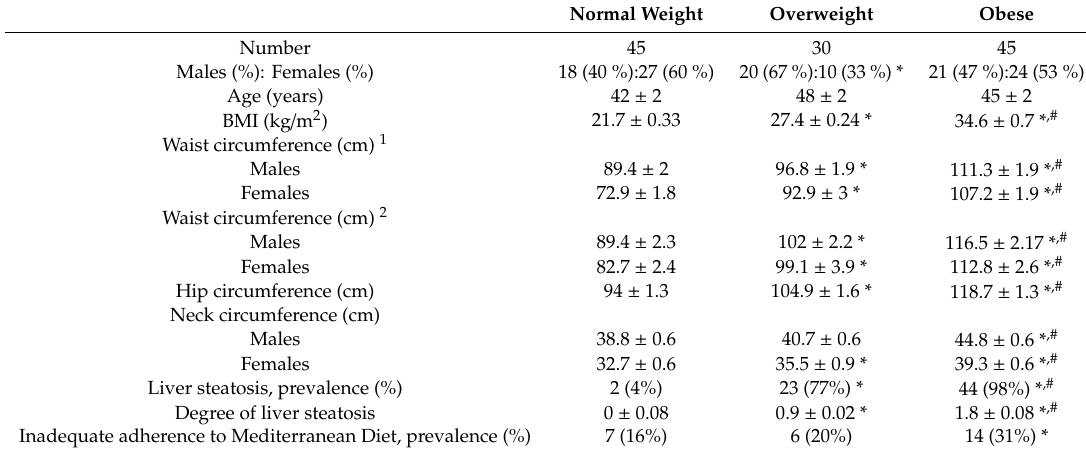
6 of 20 Table 1. Clinical characteristics of the study groups. Normal Weight